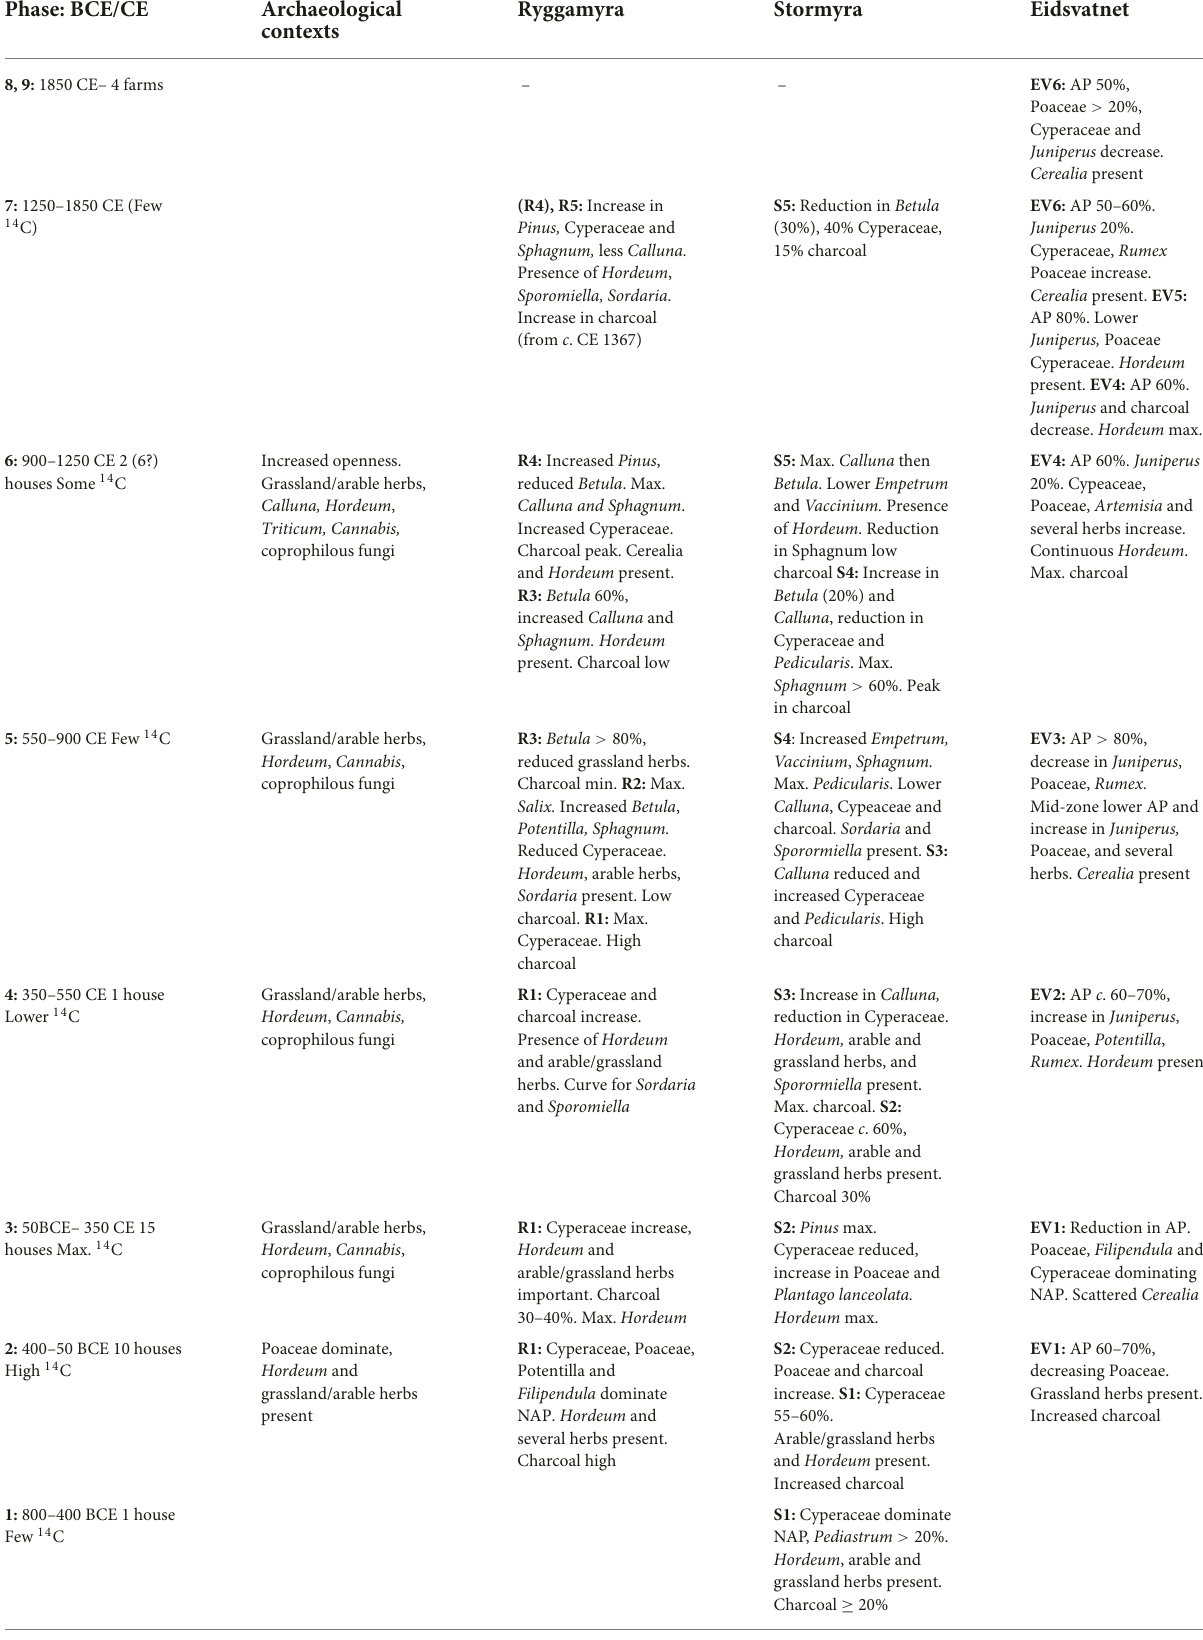
TABLE 2 Summary of pollen data in relation to the local settlement phases at